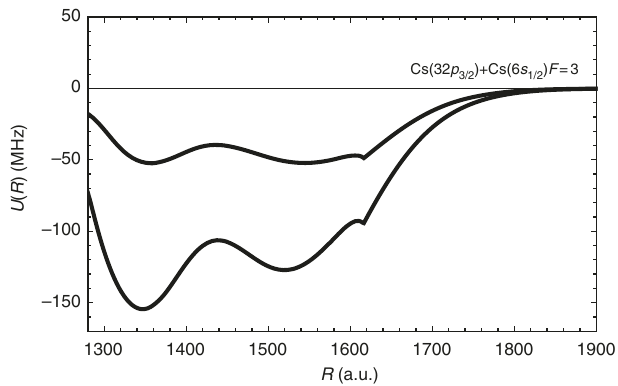
Fig. 3 Singlet/triplet mixing in Cs Rydberg molecule BO potential energy curves. The interaction potentials including spin-dependent relativistic interactions (see Box 3 for details). The lowest potential is mainly a S = 1 (triplet) BO potential for a Cs(6 s 1/2 ) - Cs(32 p 3/2 ) Rydberg molecule in the ground hyper fi ne state, F = 3. The excited BO potential curve is predominantly a spin-mixed S = 0 and S = 1 (singlet and triplet) state. Unphysical cusps can be seen in both potentials at R ~ 1629 a.u. The cusps are the result of the semi-classical description of the energy-dependent scattering length at the transition from the classically allowed to the classically forbidden region. The cusps cannot be removed at the level of approximation discussed in this review, but they have little in fl uence on the nature of molecular states of interest here. These potentials were recently employed in ref. 51 for interpretation of the observation of spin-mixed states in ref.